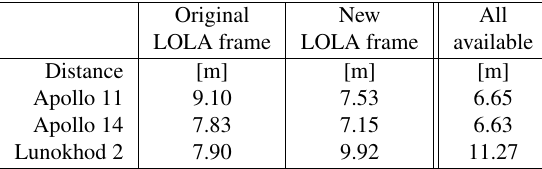
Table 3. The horizontal distances in meters between the